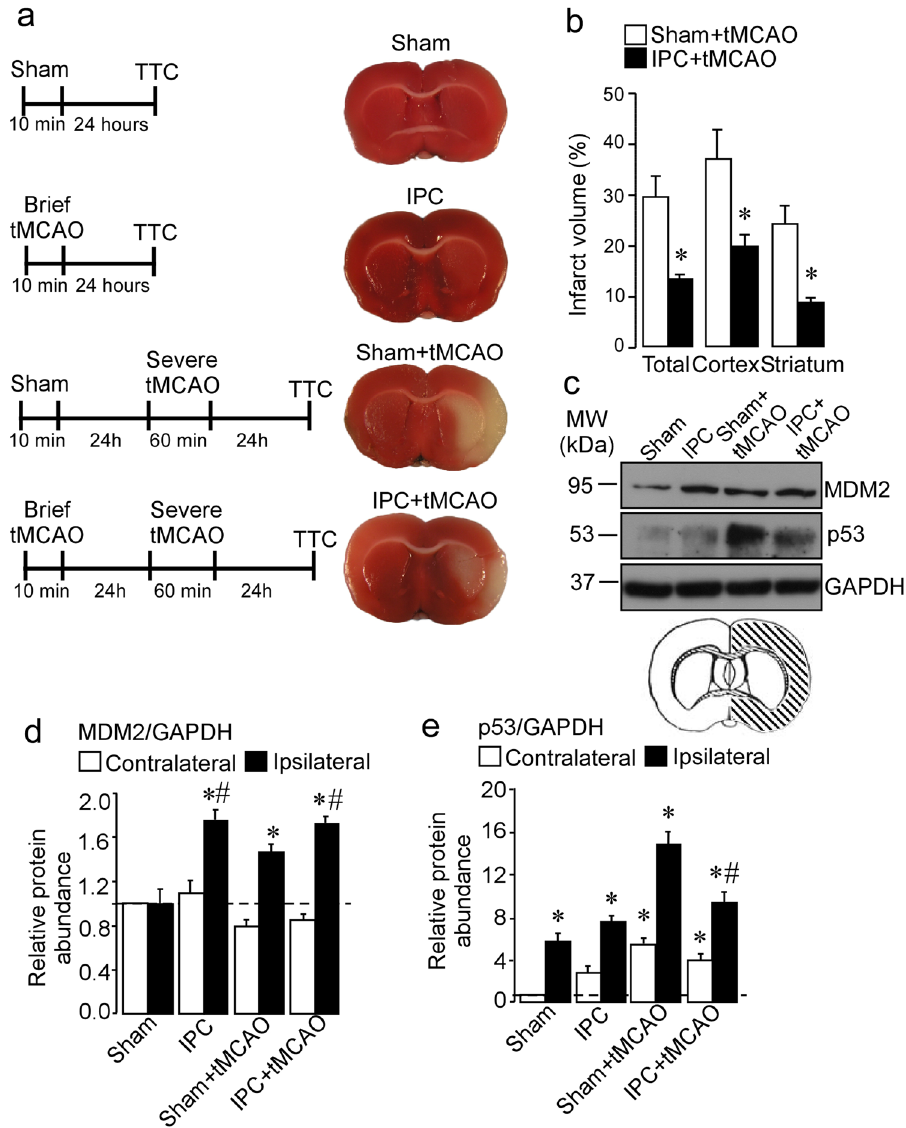
Figure 7. IPC attenuated ischemia-induced infarct growth and increases MDM2 protein levels and p53 destabilization in vivo . (a) IPC was generated by 10 min of transient occlusion of the middle cerebral artery previous to tMCAO for 60 min in rat. Sham-operated rats underwent the same surgical procedure except for tMCAO. After 24 hours of tMCAO recovery, rats were euthanized for brain TTC-staining and the results show that ( a ) IPC attenuates tMCAO-induced infarct growth by ( b ) total 60%, cortex 46% and striatum 31% in preconditioned animals (IPC + tMCAO), as compared to non-preconditioned animals prior ischemia insult (SHAM + tMCAO). ( c ) Cortical brain extracts were analyzed by western blotting and ( d , e ) the relative abundance of protein levels was quantified after 24 hours of tMCAO recovery. ( c ) IPC increased MDM2 protein levels ( d ) and promoted p53 destabilization ( e ) in the ipsilateral cortex (patterned area) in preconditioned animals (IPC + tMCAO), as compared to non-preconditioned animals previous tMCAO (SHAM + tMCAO). Representative western blot images are shown out of five. GADPH protein levels were used as loading control. Data are means ± S.E.M. (n = 5 independent western blot assays). Statistical analysis of the results was evaluated by one-way analysis of variance, followed by the least significant difference multiple range test. Student’s t-test was used for comparisons between two groups of values. In all cases, p < 0.05 was considered significant. * p < 0.05 versus Sham group # p < 0.05 versus sham + tMCAO